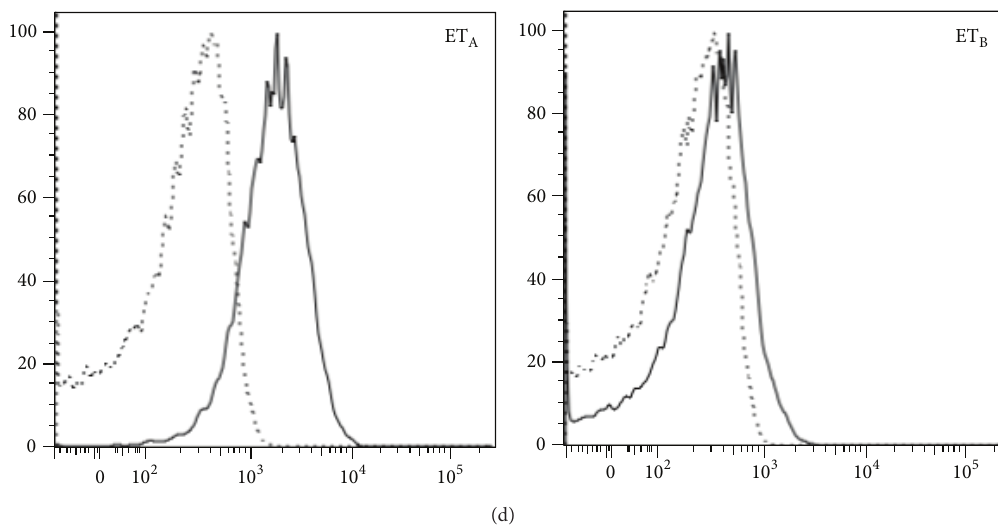
Figure 1: ET A and ET B expression by cells obtained from SSc patients. The quantification of receptors expression by T (a) and B lymphocytes (b), monocytes (c), and neutrophils (d) is represented by the difference of fluorescence intensity between the sample (continuous line) and its negative control (dotted line). The profile of one of 41 SSc patients is shown. All the other patients had a similar behaviour.